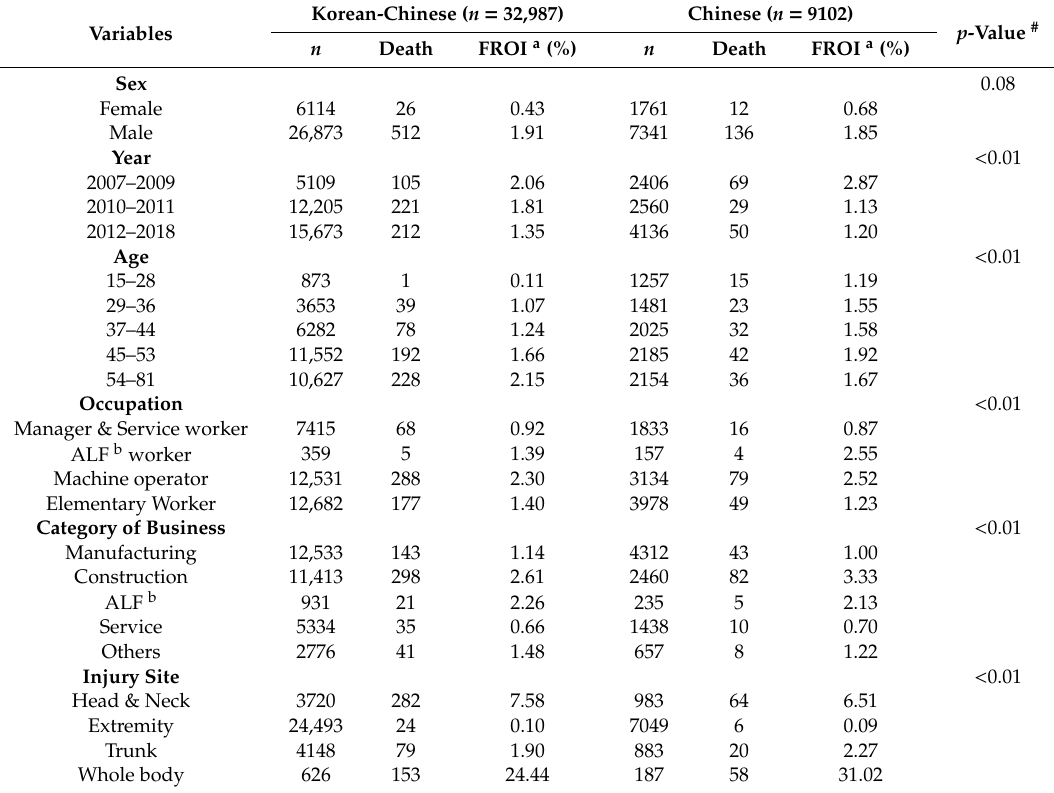
Table 3. FROI a of Korean-Chinese and Chinese migrant workers ( n = 42,089).